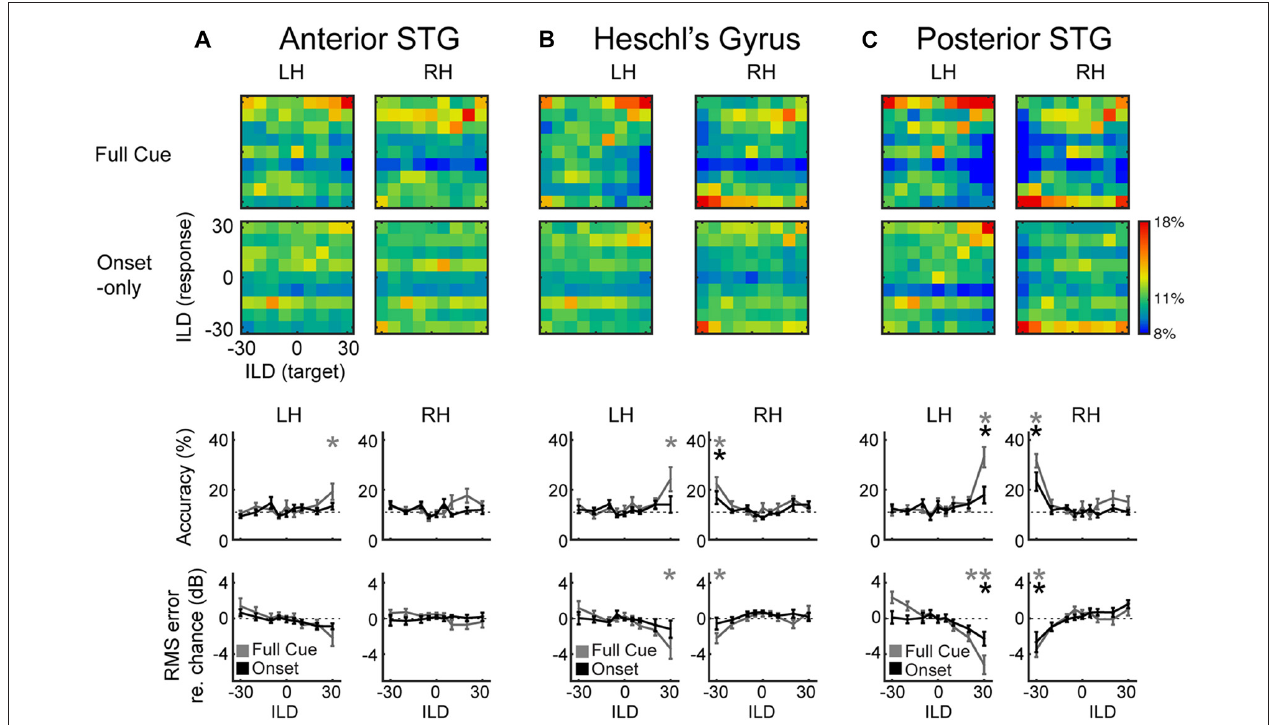
FIGURE 3 | Multi-Voxel Pattern Analysis (MVPA) results for (A) aSTG, (B) HG and (C) pSTG, show confusion matrices for the full-cue (first row) and onset-only (second row) stimuli. Color scale indicates classification rate. Target (presented) ILDs are organized along the x -axis, and response (predicted) ILDs along the y -axis. Third and fourth rows plot mean accuracy and root-mean squared (RMS) error with respect to chance, as a function of ILD for full-cue (gray) and onset-only (black) conditions. Dashed lines indicate level of chance performance (11% accuracy or 0% RMS error); asterisks indicate significant difference with respect to the permuted dataset ( p <